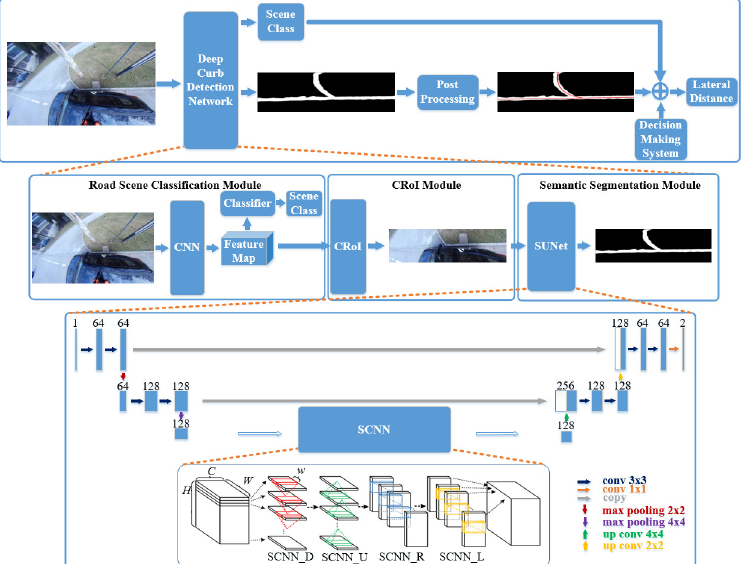
Figure 1. Hierarchical structure of the proposed mono-vision based lateral localization system. The upper layer (the first row) is the lateral localization system. Depending on the curb detection results, the vehicle calculates the lateral distance between itself and the nearest road curb which is then sent to the vehicle control system. The middle layer (the second row) is the core component of our system, which is a deep curb detection network. It consists of three important modules: road scene classification module, curb region of interest module, and semantic segmentation module. The bottom layer (the third row) shows the network architecture of our semantic segmentation module, which is built based on U-Net [17] and SCNN